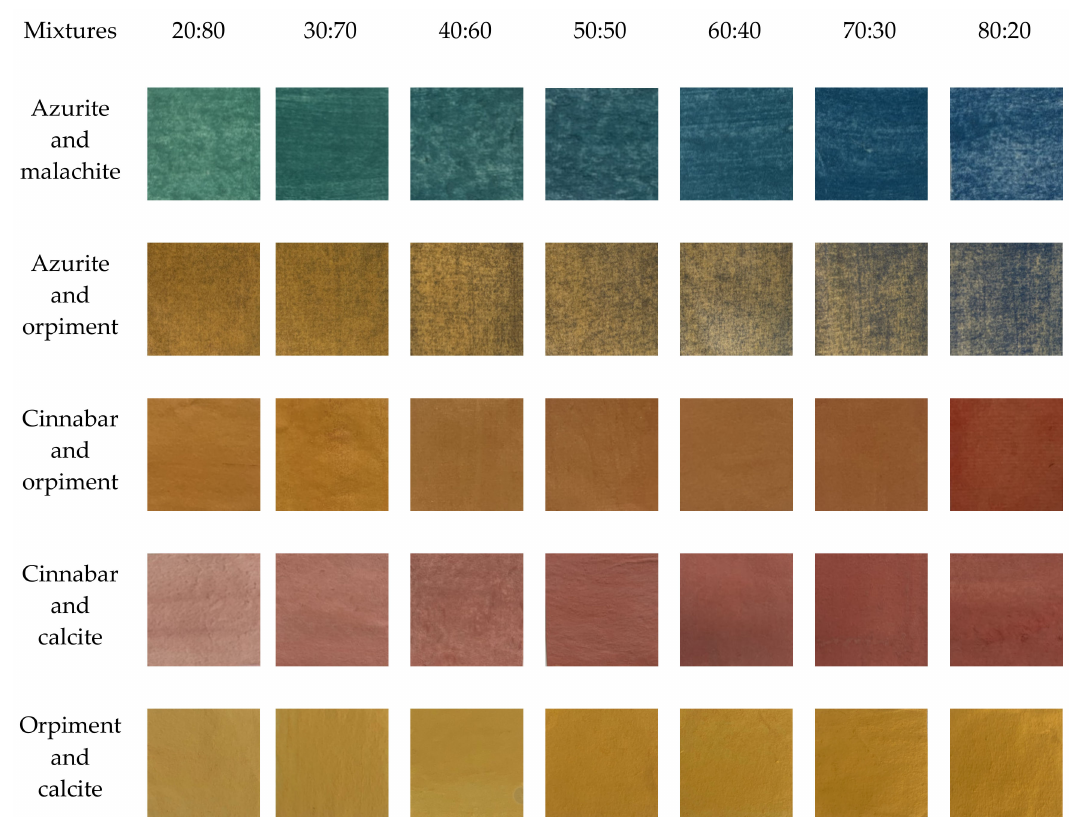
Figure 2. The five groups of sample blocks with mixed